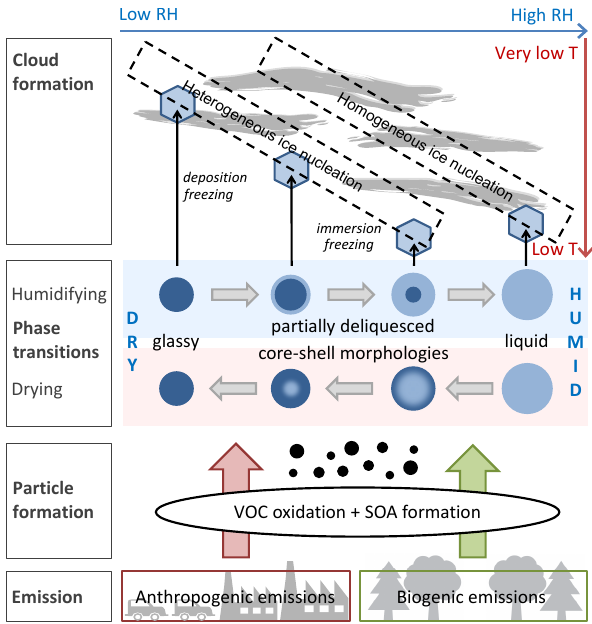
Figure 5. Overview of processes in organic aerosol particles af- fecting atmospheric cloud formation. Particles form by oxidation of volatile organic compounds (VOCs) originating from anthro- pogenic and biogenic emissions. The dominating cloud formation process depends on particle phase state, which is a function of tem- perature and humidity. Humidity-induced phase transitions between phase states may be kinetically limited and occur under formation of partially deliquesced particles with core-shell morphologies. Glassy or partially deliquesced particles are able to undergo heterogeneous ice nucleation, occurring at lower relative humidity or higher tem- perature than homogeneous ice nucleation of liquid